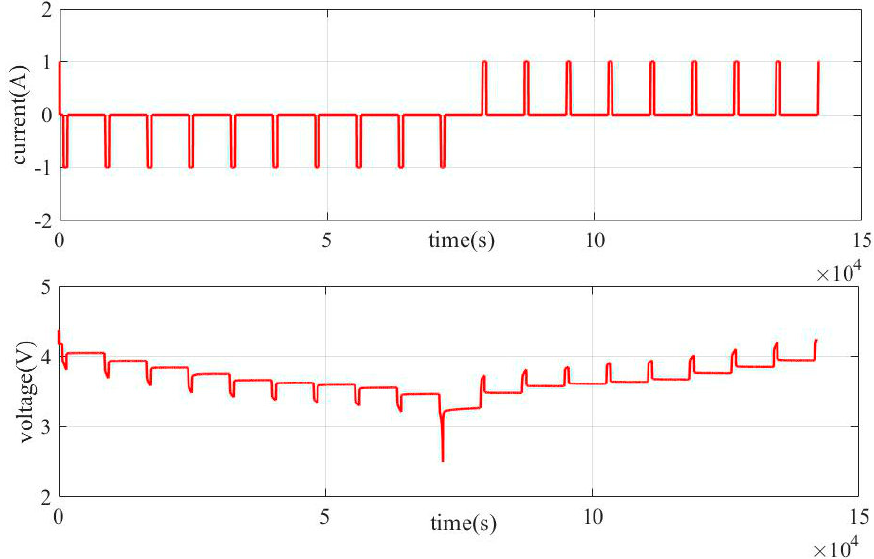
Figure 5. Current and voltage of the incremental current test. Table 4. Model parameters and statistics.